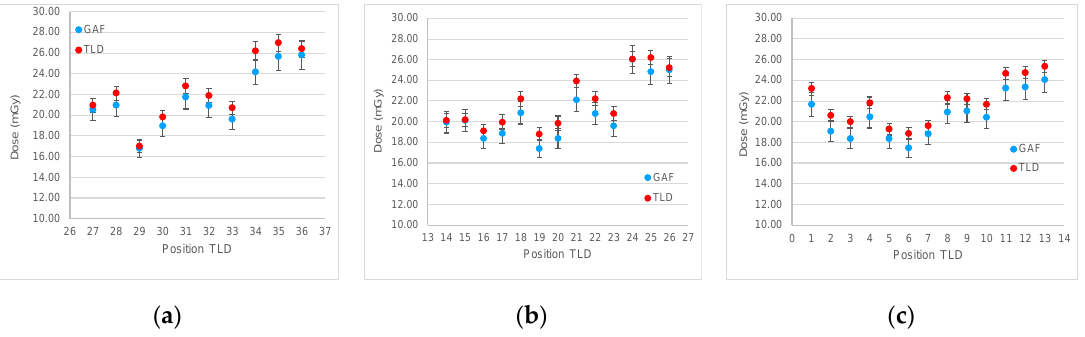
Figure 6. Average dose values for Gafchromic TM XR-QA2 (blue dot) and TLD 100H (red dot): ( a ) dose values trend for the 17th slab; ( b ) dose values trend for the 18th slab; ( c ) dose values trend for the 19th slab.